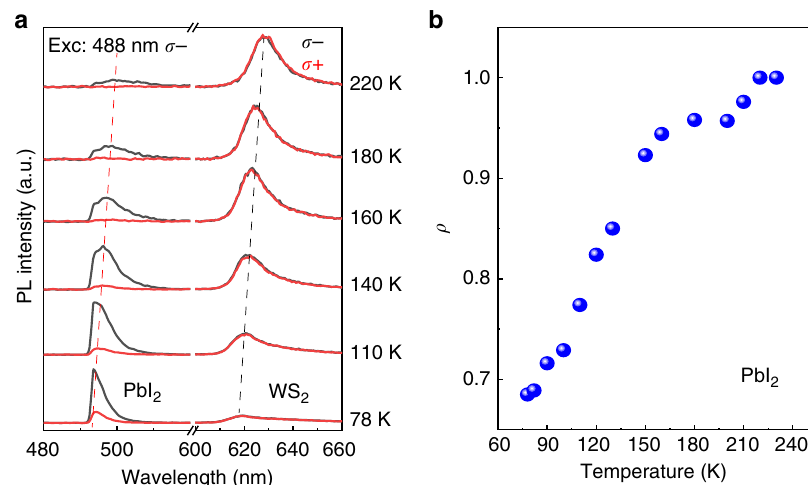
Fig. 4 Temperature-dependent degree of polarization from PbI 2 /WS 2 heterostructures. a Circularly polarized PL spectra of PbI 2 /WS 2 heterostructure at different temperatures for excitation with a 488 nm σ − polarized CW laser beam. b Degree of polarization ρ of PL from PbI 2 as a function of temperature, showing a decreasing tendency at lower